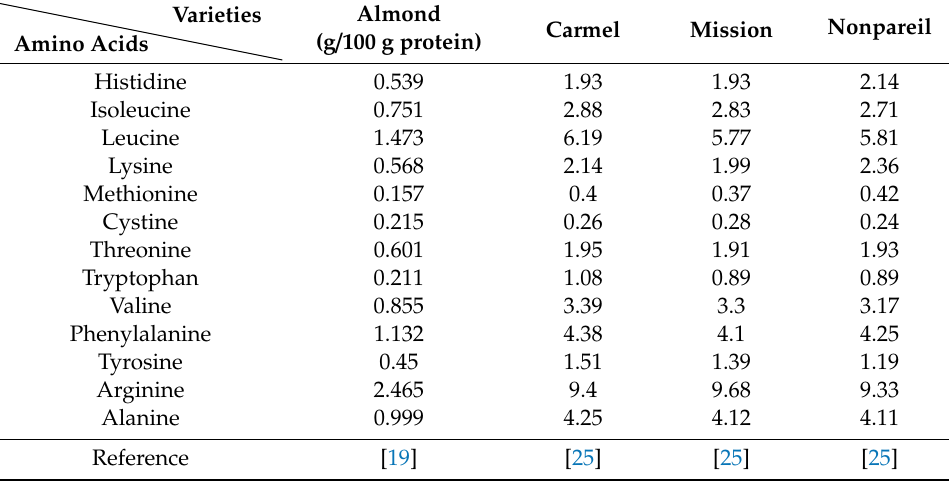
Table 5. Amino acid content of di ff erent varieties of almonds ( Prunus dulcis Mill. D. A. Webb). Varieties Almond Amino Acids